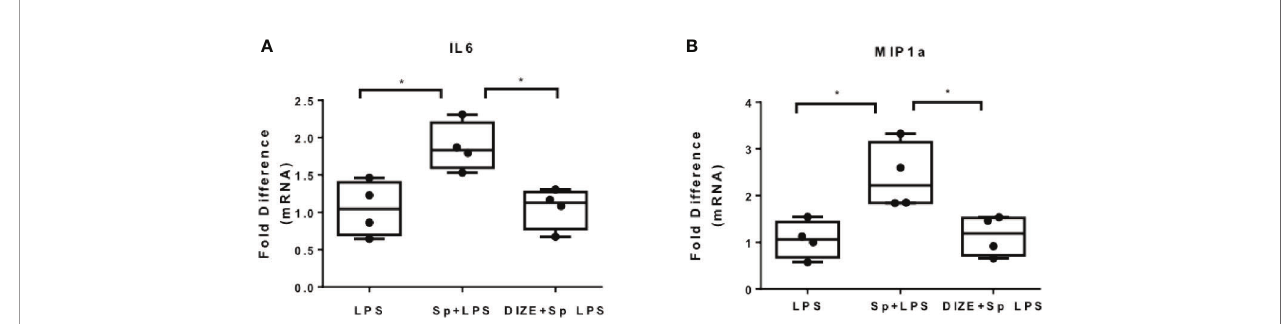
FIGURE 6 | ACE2 activator Diminazene Aceturate (DIZE) reverses the in fl ammatory status provoked by SARS-CoV-2 S protein. (A, B) LPS- induced MIP1a and IL6 expression decreased in THP-1 macrophages pre-treated with DIZE for 6 hours. Data are illustrated in box-and-whiskers and plotted as median (± min, max). Statistical analysis was performed with Kruskal - Wallis test. *p < 0.05.